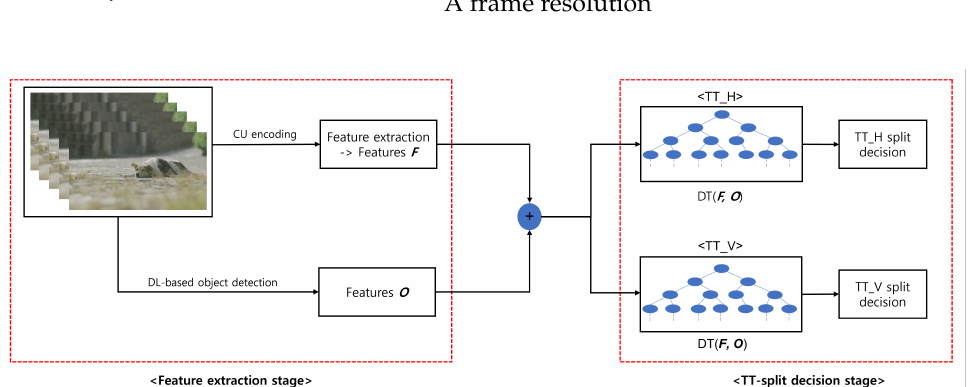
Figure 1. Framework of the proposed object-cooperated ternary tree (TT) partitioning decision method. Features F denotes the context-based features obtained by coding unit (CU) encoding, and Features O denotes the object-features obtained via object detection.